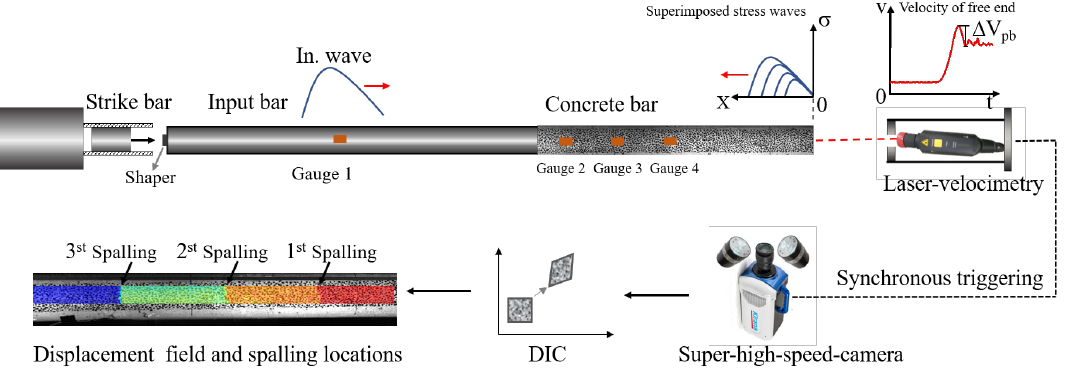
Figure 4. Schematics illustrating the spalling tests combining with the technique of ultra-high- speed camera and DIC